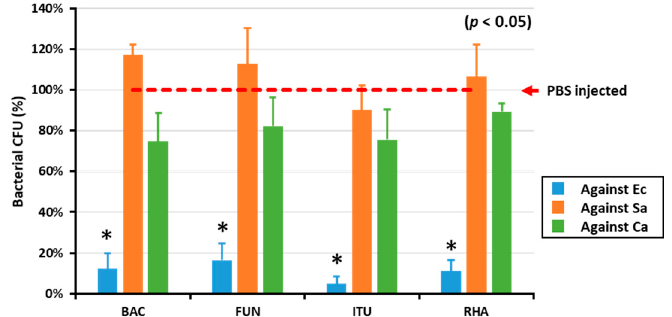
Figure 1. The in vitro AMP activity of biosurfactant-immune activated larvae against microbes. The in vitro AMP activities of biosurfactant-immune activated larvae against Gram-positive ( S. aureus , Sa), Gram-negative bacteria ( E. coli , Ec), and fungi ( C. albicans , Ca) were measured by mixing the hemolymph of immune-activated larvae and the microbes. Excitingly, the results revealed that all the tested biosurfactants including bacitracin (BAC), fengycin (FUN), iturin A (ITU), and rhamnolipid (RHA) significantly ( p < 0.05) reduced E. coli growth, compared with the PBS-injected control group (red dotted line).* significant difference ( p < 0.05) of CFU, compared to the PBS-injected group.